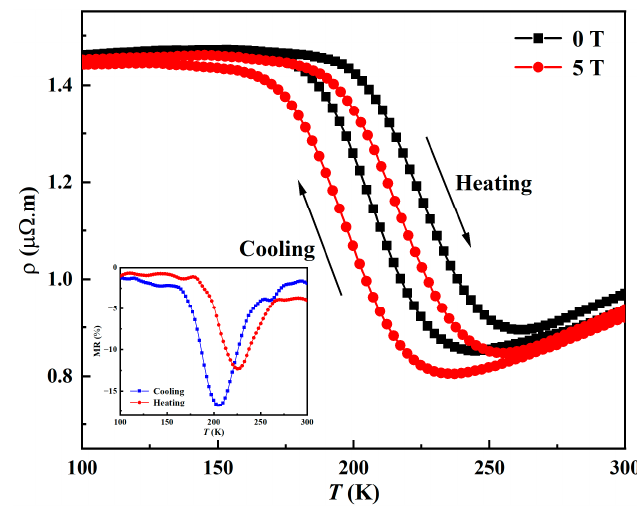
Figure 8. Electrical resistivity as a function of temperature under 0 and 5 T magnetic fields. Inset: Magnetoresistance vs. temperature curves under 5 T magnetic fields.